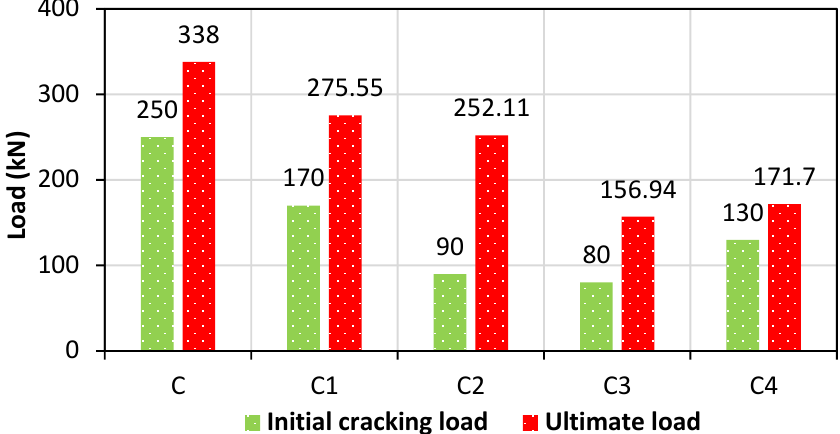
Figure 35. Initial cracking load and ultimate load of the specimens.